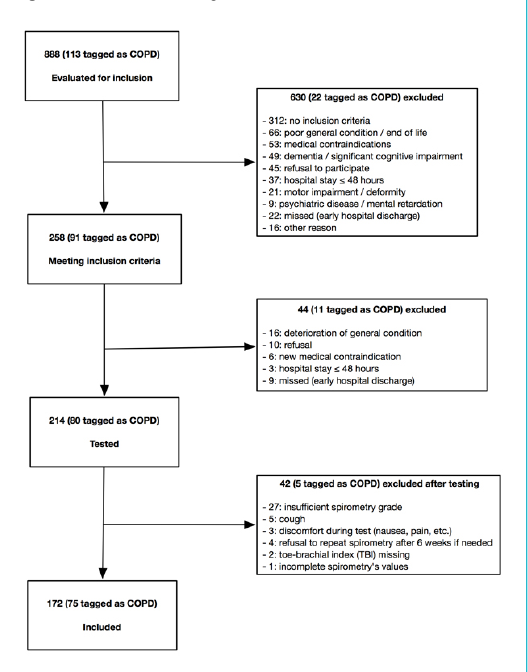
Figure 1: Patient screening and inclusion.